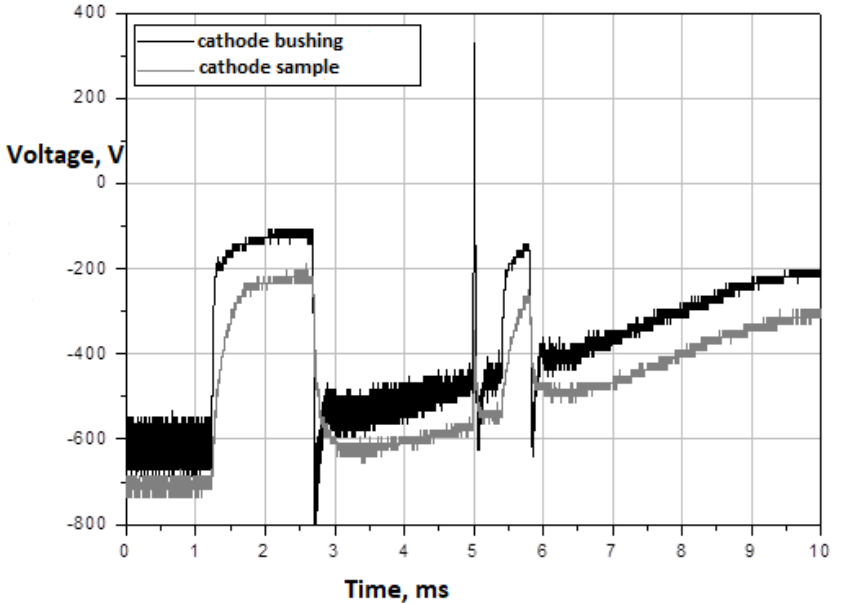
Figure 9. Comparison of the potentials at the cathode bushing (top) and on the surface of the control sample with galvanic contact with the cathode (bottom)—an elementary graduation of 1 ms.